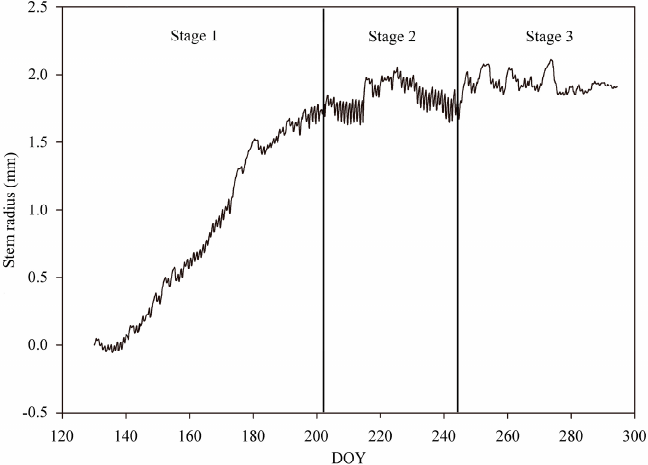
Figure 4. Mean stem radius of four trees during the whole study period, and the three stages: stage 1 with the most rapid growth; stage 2 with persistent shrinkage; and stage 3 with minimal growth. The values are the mean stem radius of four trees.